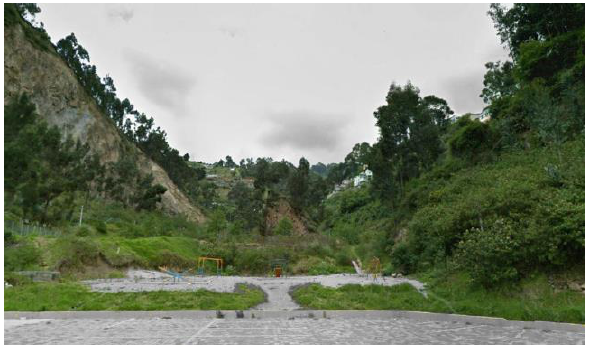
Figure 5. Closer point of Jerusalén